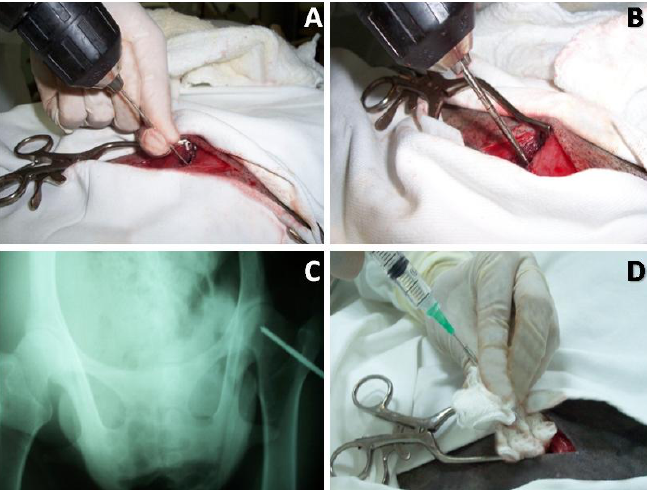
FIGURE 1 – Central decompression technique of the femoral head with injections of absolute ethanol. A . Passage of the 1 mm Kirschnner from the greater trochanter to the center of the femoral head. B. Passage of the 3.5 mm cannula drill through the great trochanter to the center of the femoral head. C . Radiographic image of the correct position of the cannula drill. D. Injection of absolute ethanol into the center of the femoral